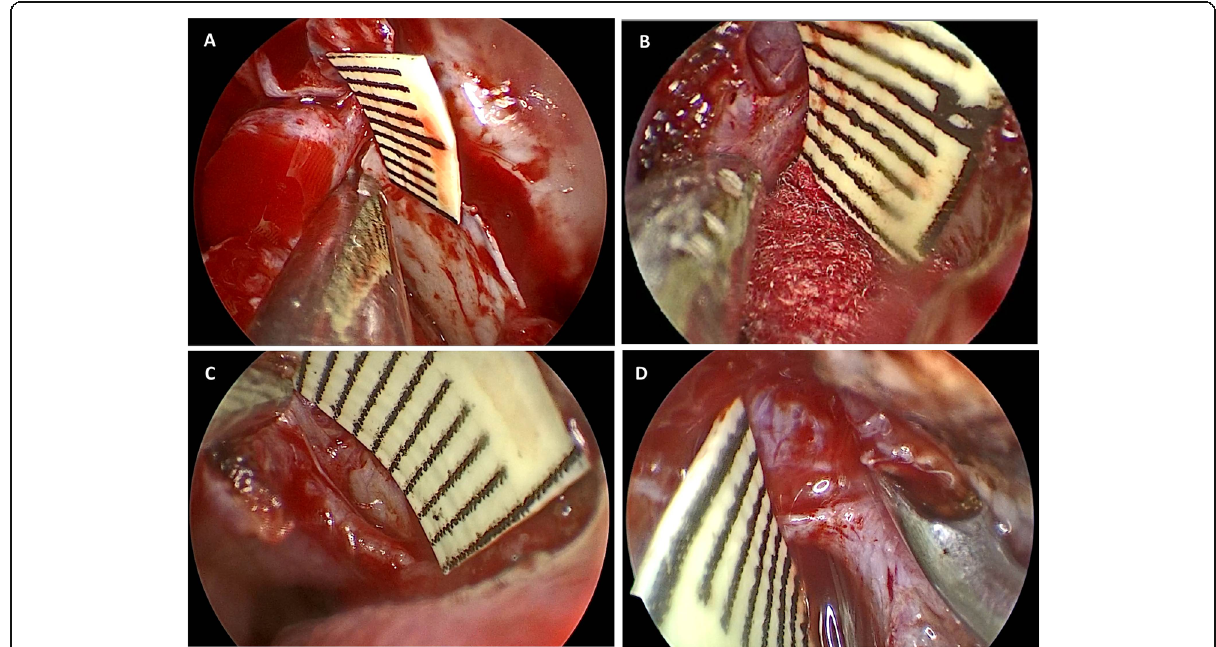
Fig. 2 a – d Intraoperative measurement variations of SPA diameter between 2 groups. a, b 2 cases from group A; 4.5-mm and 5-mm diameter, respectively. c , d 2 cases from group B; 3-mm diameter for